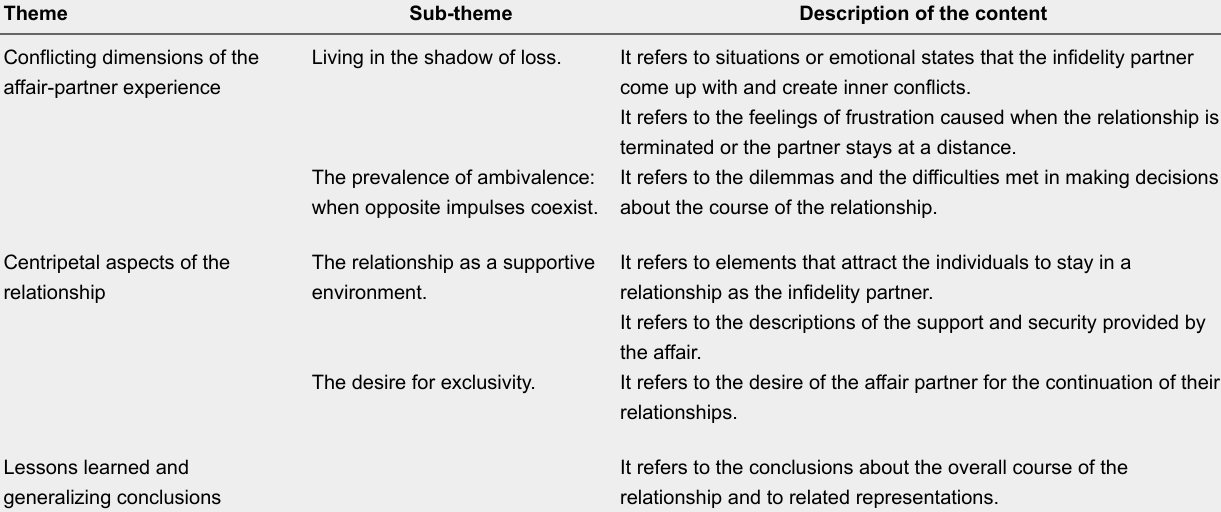
Description of the Themes and Sub-themes Theme Sub-theme Description of the content Conflicting dimensions of the affair-partner